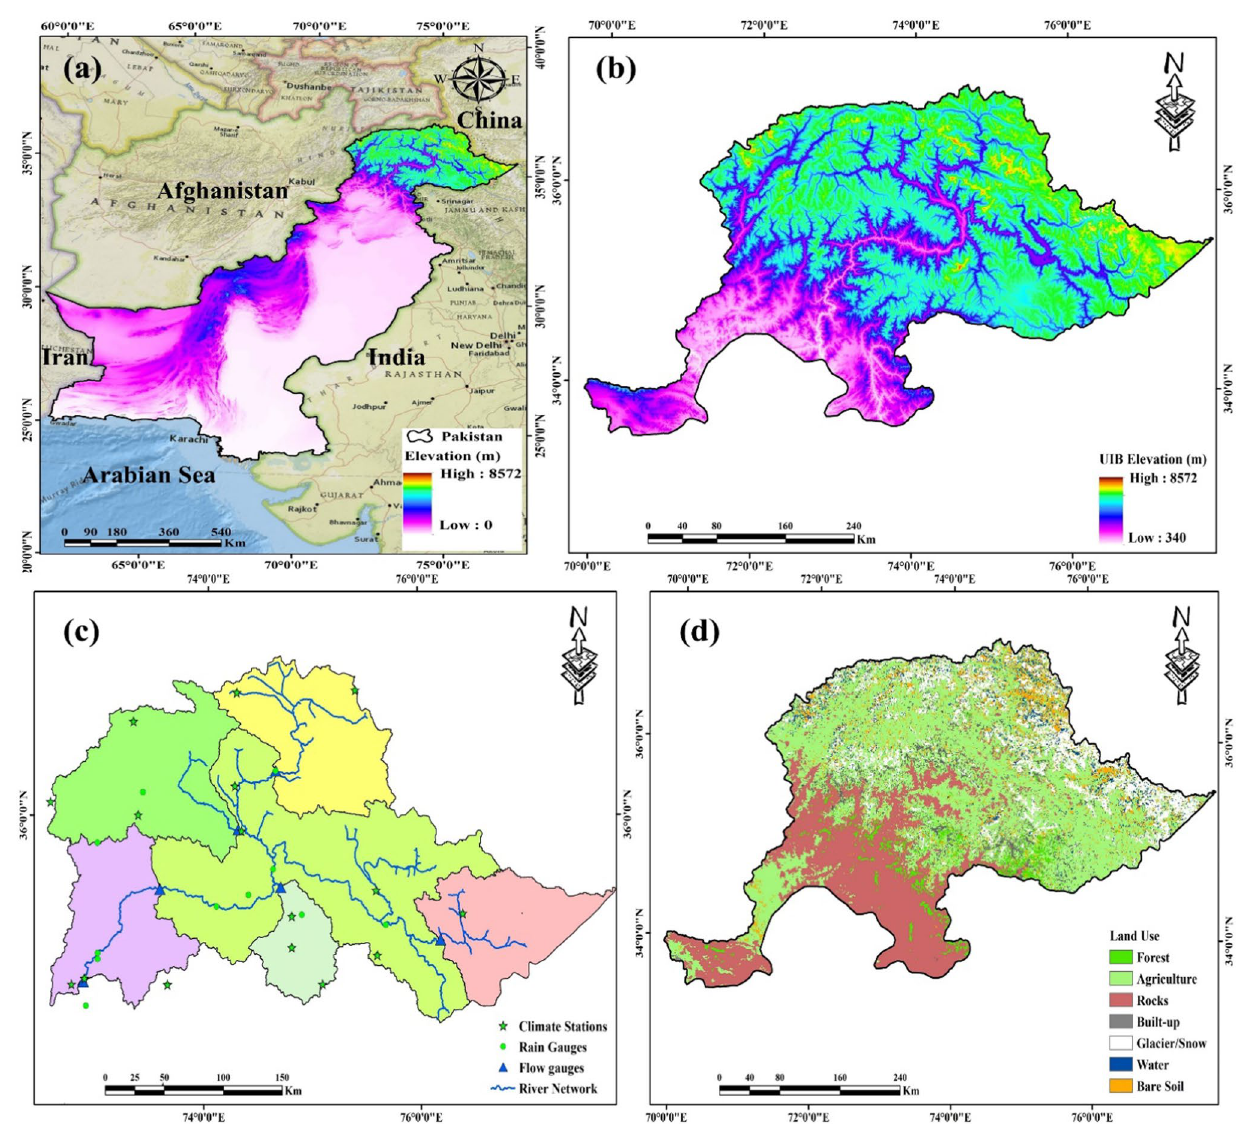
Fig. 1 Detailed information about the study area, a geographical location and elevation of Pakistan, b elevation of UIB, c selected basins and the distribution of rain gauges, climate and streamflow stations, d land use of